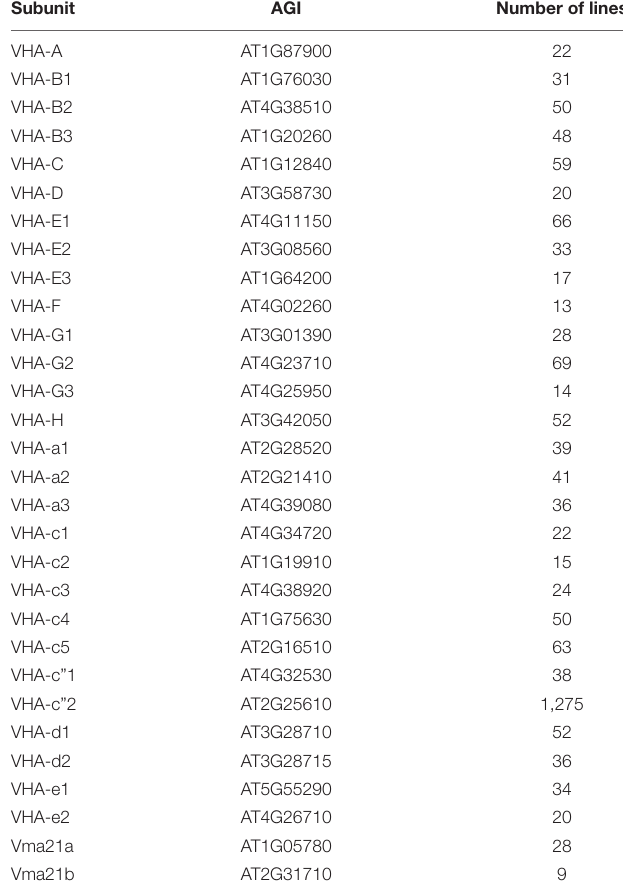
TABLE 3 | Available insertion lines of VHA